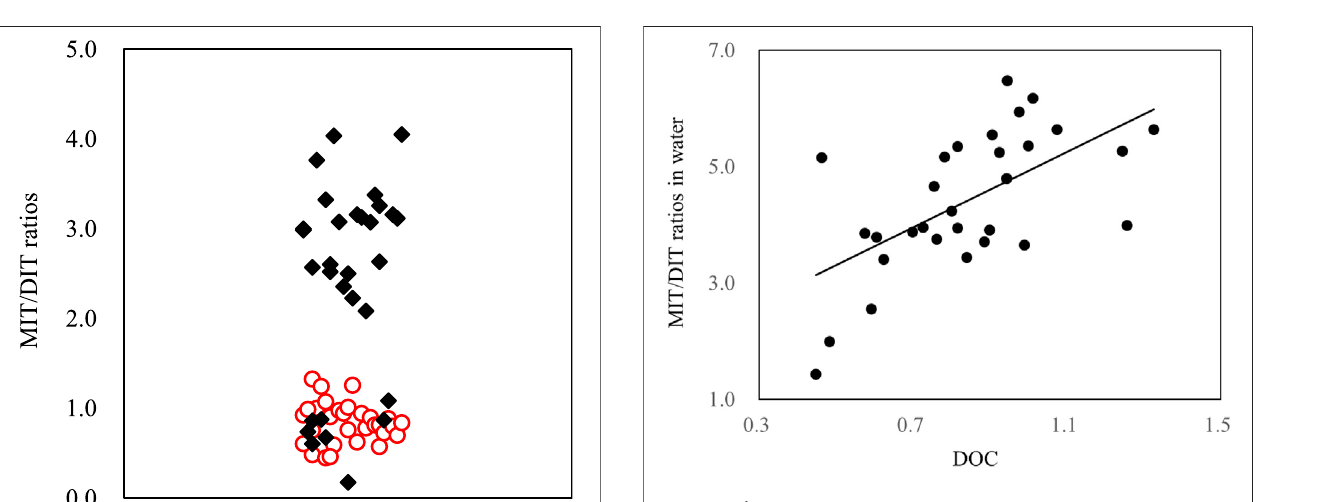
FIGURE 5 | Correlations between the concentration ratios of MIT and DIT and DOC values (mg/L) in water samples of Taihu Lake in